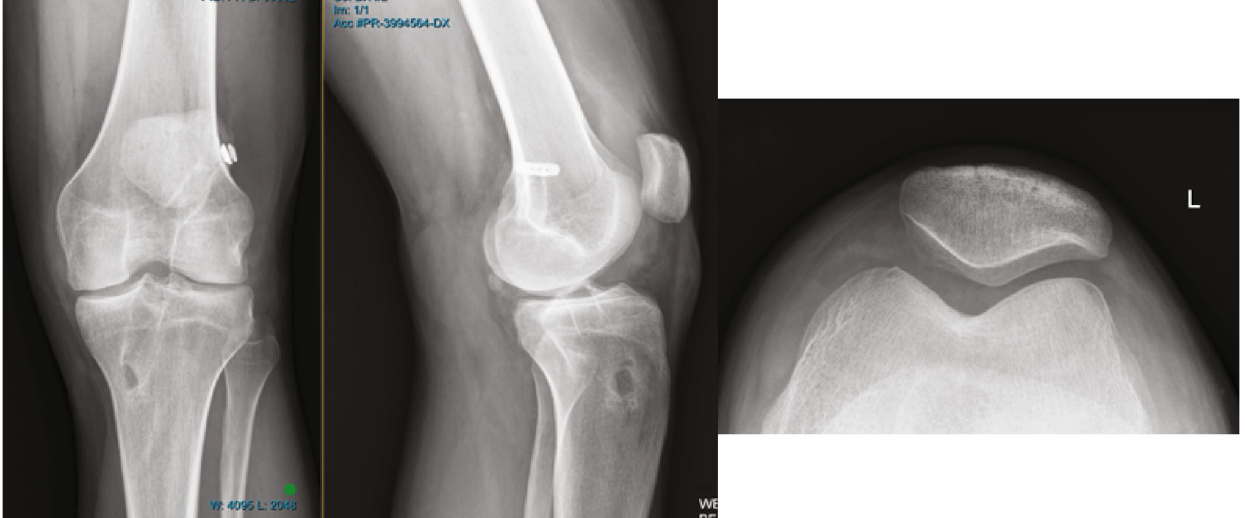
Figure 2: Radiograph in 2016 of BP ’ s left knee.